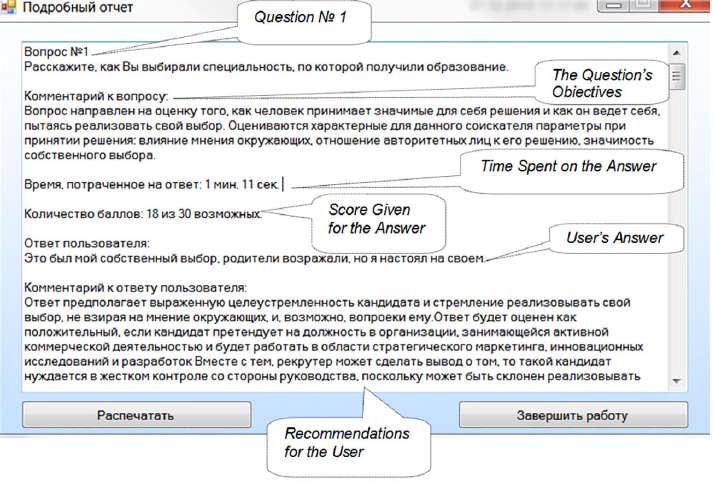
Figure 1. Detailed comments to the answer the question Nº